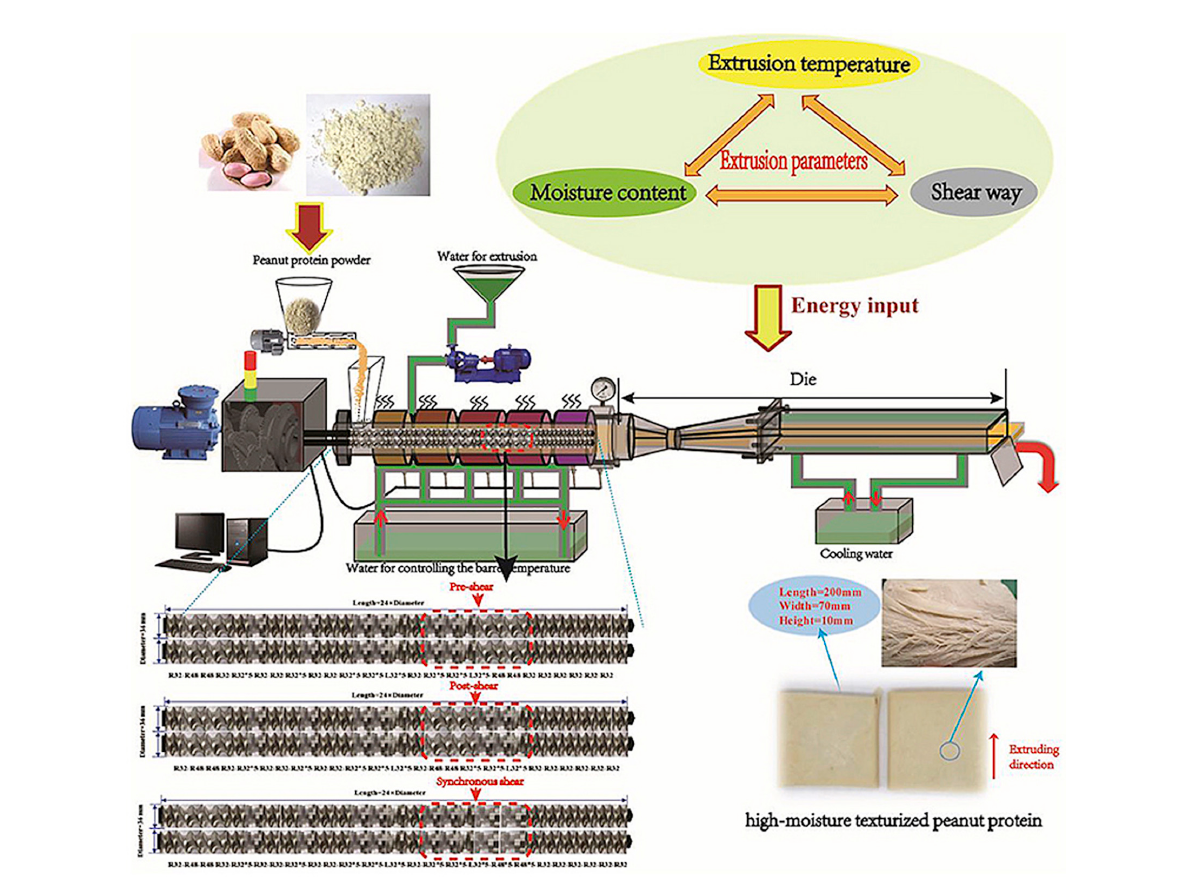
FIGURE2 A new insight into the high-moisture extrusion process of peanut protein: from the aspect of the energy input orders and amount [Adapted from Zhang et al.